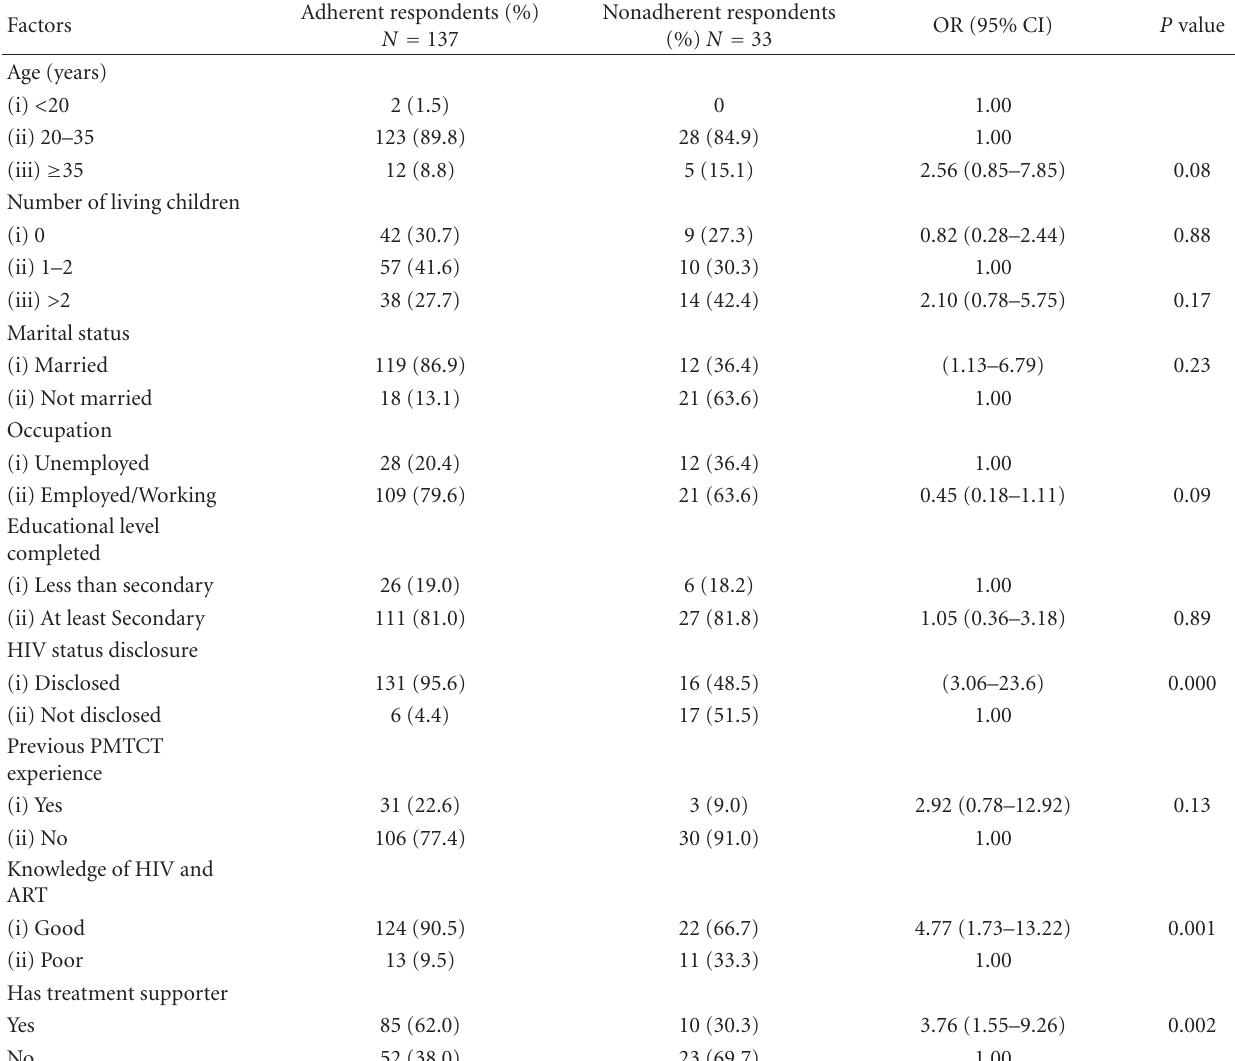
Table 5: Factors associated with good adherence among the